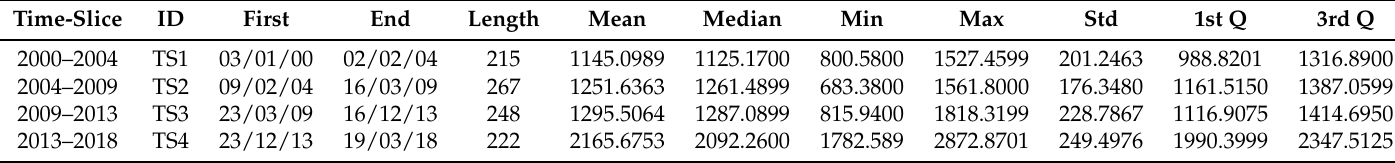
Table 4. Main statistics for the observed block on the S&P